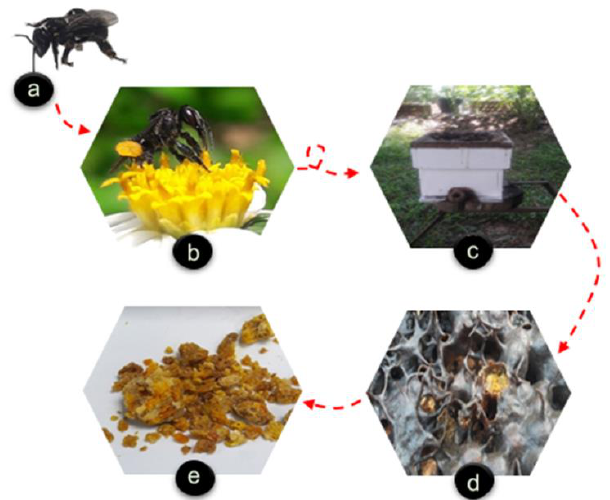
Figure 4. Process of stingless bees collecting and producing bee pollen: ( a ) stingless bee, ( b ) bee collecting pollen, ( c ) stingless bee bringing pollen to hive, ( d ) pollen stored in cerumen pots, and ( e ) harvested bee pollen. Reprinted with permission from Ref. [108]. 2021, MDPI.